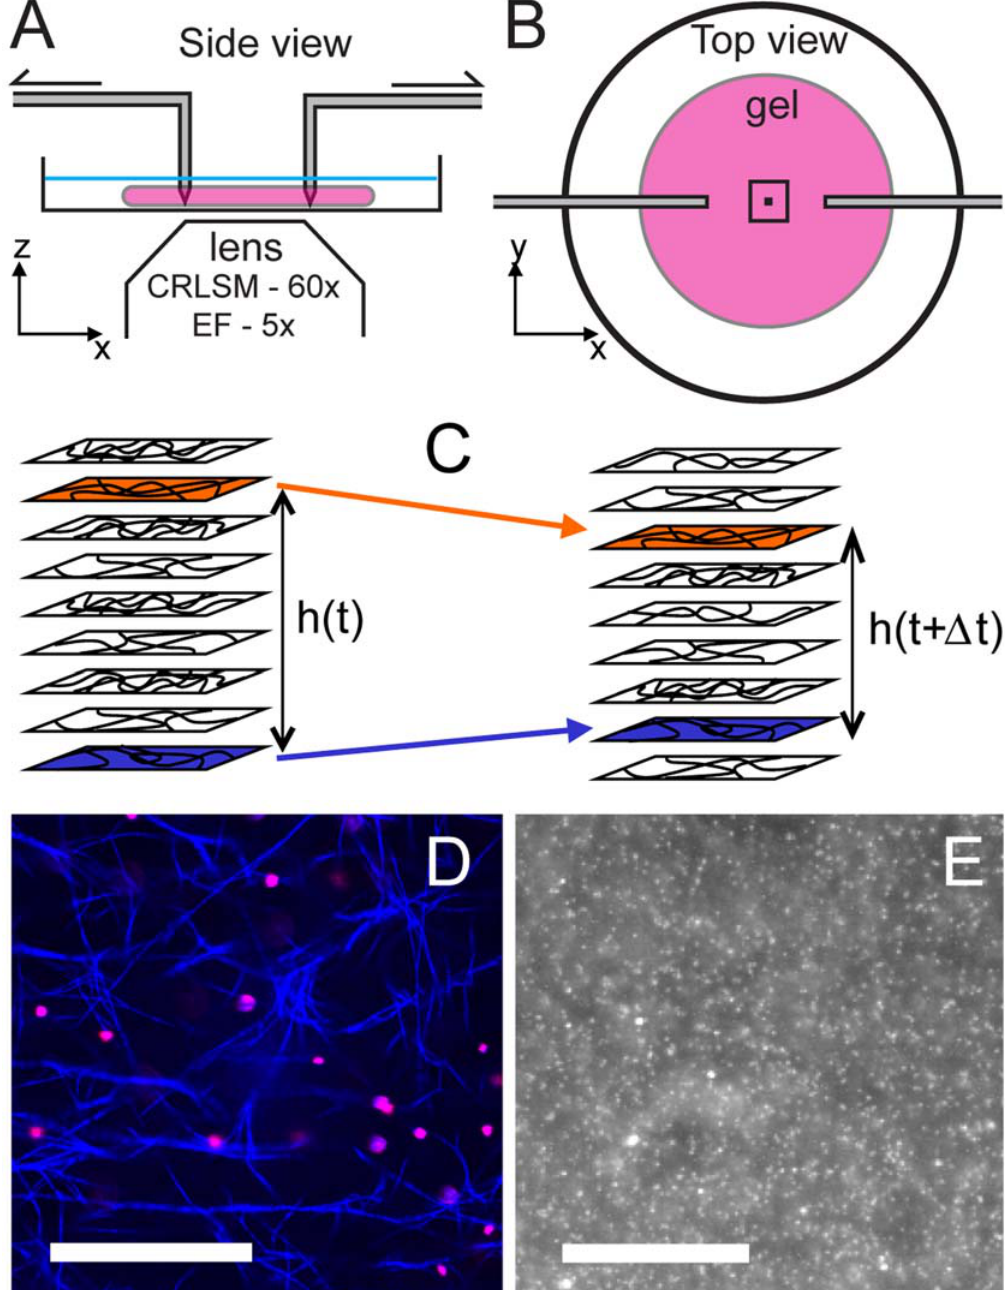
Figure 2. Mechanical setup and sample imaging. (A) Side and (B) top views of the mechanical setup used to deform the network; the collagen gel has a pancake-like shape, typically 1 mm in thickness and 20 mm in diameter. As defined in our experiments, the stretch axis is x . Drawn to scale, the two squares represent the fields-of-view of the wide-field fluorescence images (5 6 ) and confocal reflectance images (60 6 ). (C) Correlation of multiple slices over time gives an estimate of the interslice distances, and hence vertical strain. (D) Collagen network (blue) obtained with confocal reflectance. Fluorescent tracers (pink) are embedded in the network. Scale bar 20 m m. (E) Wide-field fluorescence image of the embedded beads. Scale bar 500 m m.